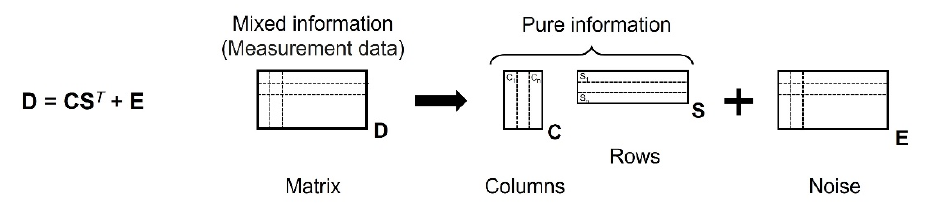
Figure 3. A principle of multivariate curve resolution (MCR).